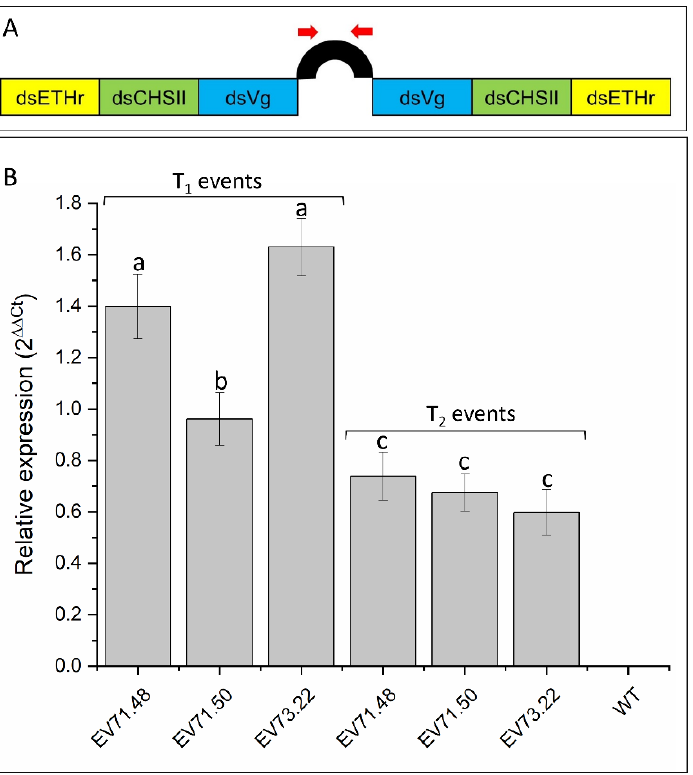
Figure 5. Expression of the dsRNA loop region in cotton buds oviposited by A. grandis females. ( A ) Graphical representation of the dsRNA-expressing region in transgenic cotton plants. Red arrows indicate the position of the fragment used for qPCR assessment. ETHr: Ecdysone-triggering hormone receptor. CHSII: chitin synthase II. Vg: vitellogenin. ( B ) Relative expression of transcripts quantified by RT-qPCR using the ∆∆ Ct method. N: nine buds per plant, three plants per event. Different lowercase letters indicate significant differences between treatments ( t -test, Bonferroni corrected; p -value < 0.05).